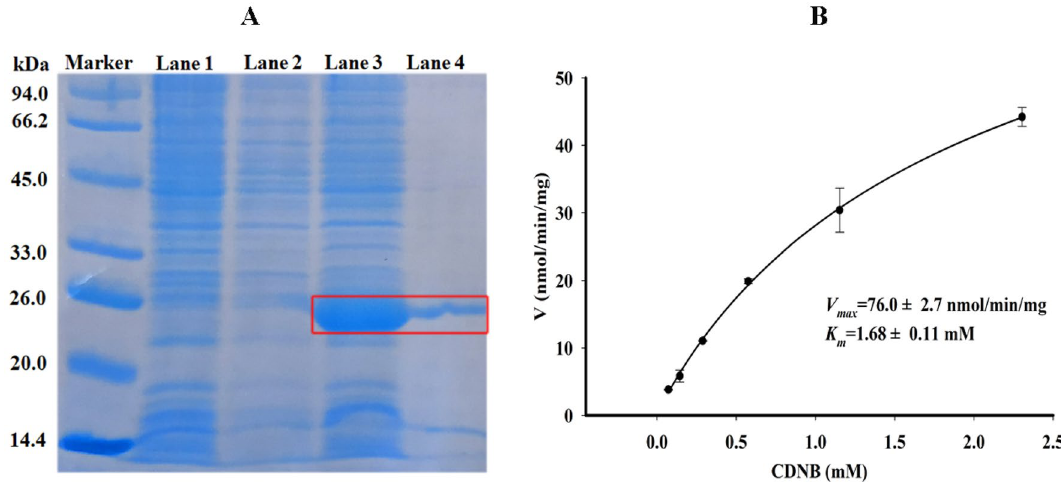
Figure 1. Electrophoresis of recombinant protein SlGSTD1 and its kinetic properties. ( A ) SDS-PAGE electrophoresis of recombinant protein SlGSTD1. The region of the target recombinant protein was indicated by a red box. Lanes from left to right represent: Marker, protein marker, Lane 1, pET-26b(+) protein extract, Lane 2, pET-26b(+)/ SlGSTd1 protein extract, Lane 3, pET-26b(+)/ SlGSTd1 protein extract induced by isopropyl β-D- thiogalactopyranoside (IPTG), Lane 4, purified SlGSTD1. ( B ) The K m and V max values of SlGSTD1 calculated with CDNB as a substrate. Original blots/gels are presented in Supplementary Fig.